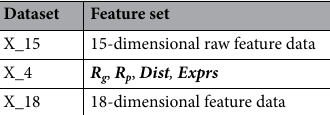
Table 4. Three combinations of